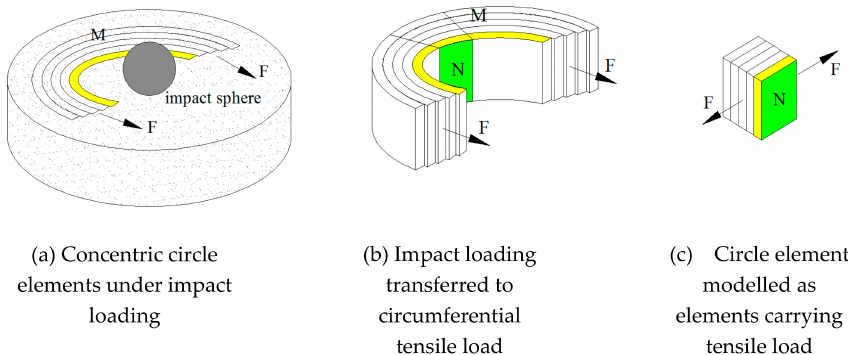
Figure 12. Elements of PVA-FRCM disc subjected to impact hammer dropping.